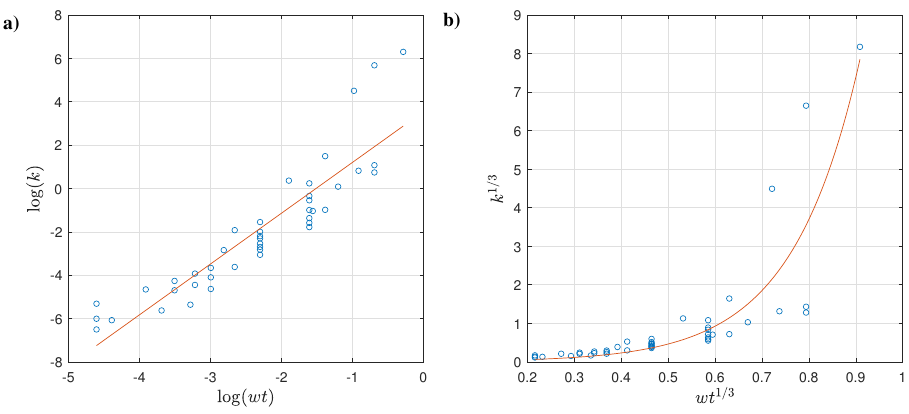
Figure 9. Best ( a ) linear and ( b ) non-linear regressions for the XG dataset.